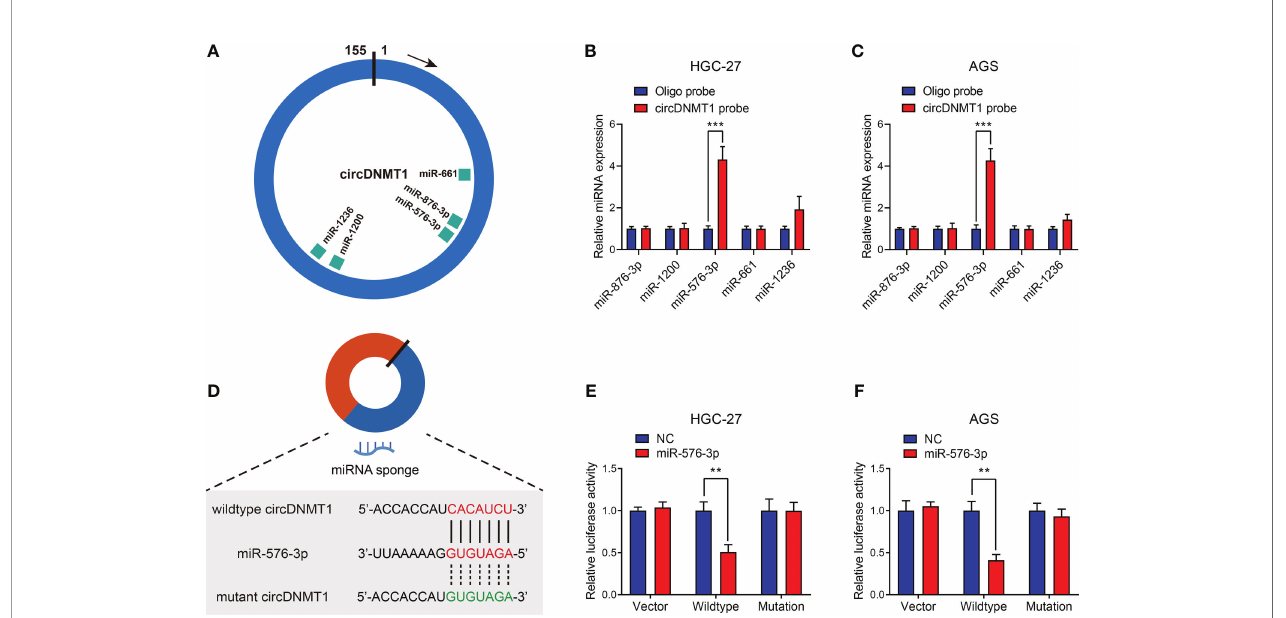
FIGURE 4 | miR-576-3p is directly sponged by circDNMT1 in GC. (A) The schematic illustration of miRNAs that can be sponged by circDNMT1 predicted by Circinteractome. (B, C) The qRT-PCR analysis to show the miRNA levels that were pulled down by NC probe or circDNMT1 probe in HGC-27 (B) and AGS (C) cells. (D) The schematic illustration of wildtype (red) and mutant (green) sequences of binding sites of circDNMT1 and miR-576-3p. (E, F) Luciferase reporter assay to show the relative luciferase activities in HGC-27 (E) and AGS (F) cells that were cotransfected with empty luciferase reporter plasmids (vector) or plasmids inserted with wildtype or mutant sequences and NC and miR-567-3p mimics. **P < 0.01, ***P <